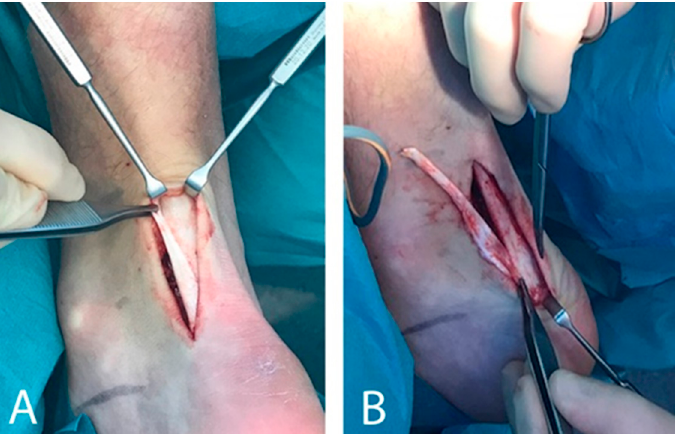
Figure 1. A wide and thick plantaris tendon ( A ) that is surgically released ( B ) from the medial side of the Achilles midportion.